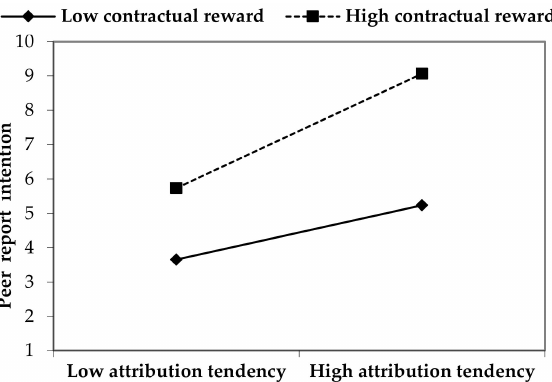
Figure 3. Moderating Effect of Contractual Reward on the Relationship between Attribution Tendency and Peer Report